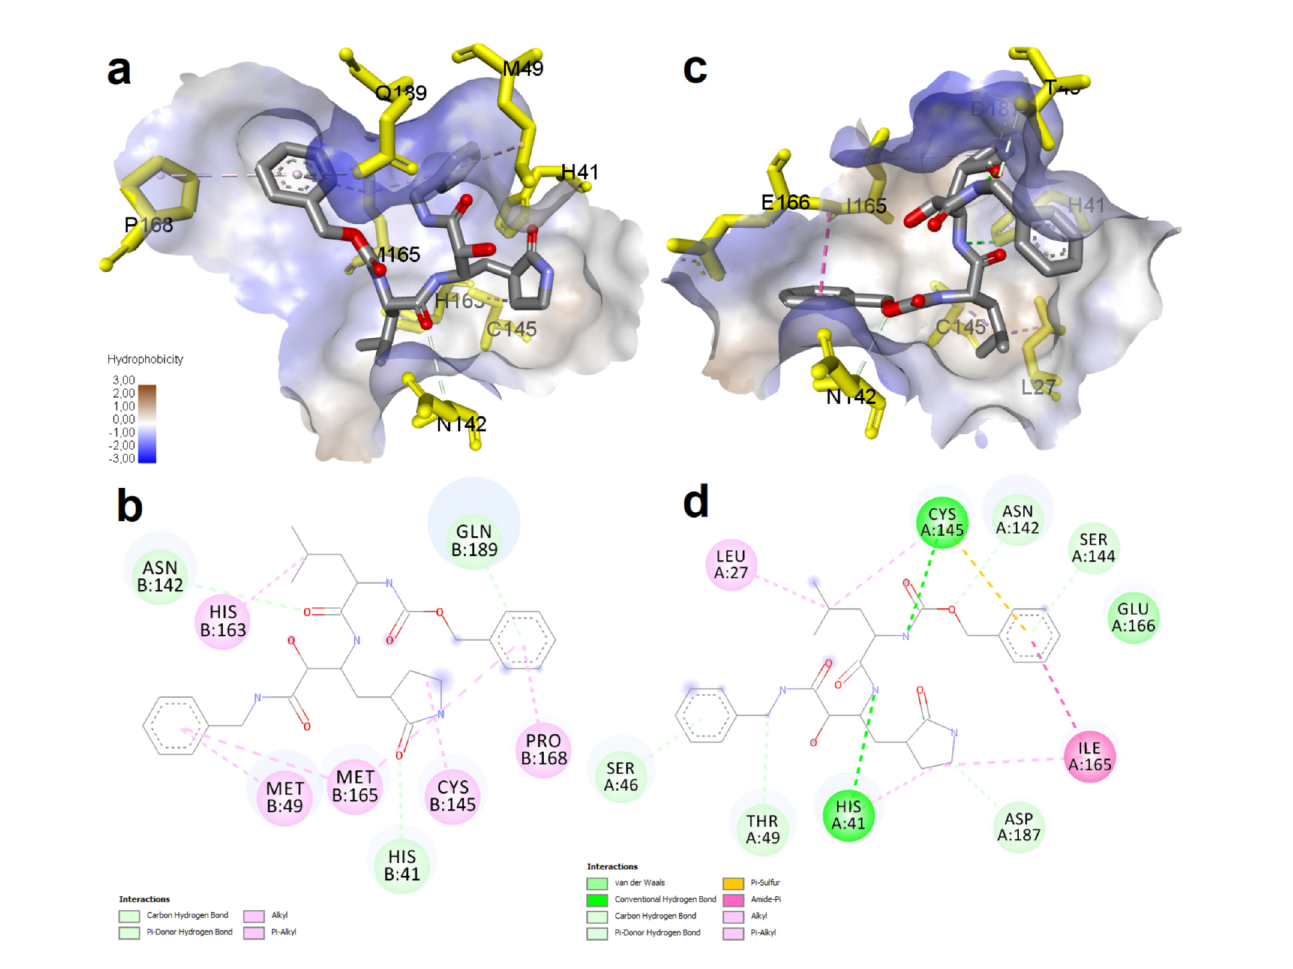
Figure 2 - Representation of binding interaction of VR4 inhibitor ligand with 3CL pro of SARS CoV-2. a) Hydrophobic surface illustration of wild-type 3CL pro -ligand complex, b) Diagram illustration of mutant 3CL pro -ligand complex, c) Hydrophobic surface illustration of wild-type 3CL pro -ligand complex, d) Diagram illustration of the mutant 3CL pro -ligand complex